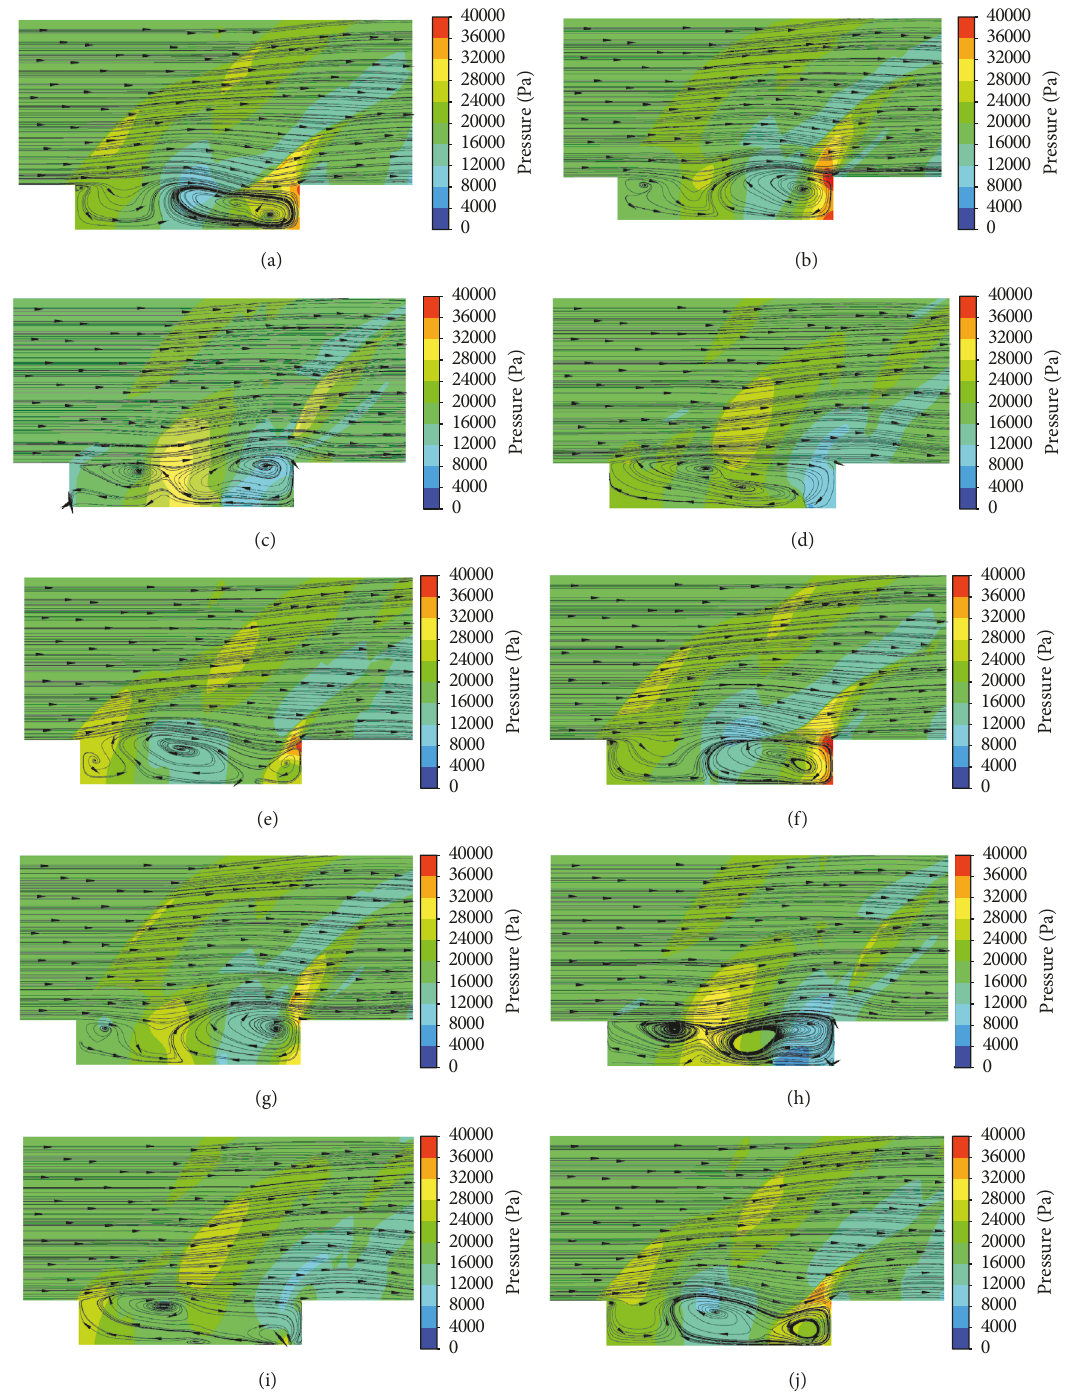
Figure 5: Pressure fluctuations of the whole domain for the baseline case (a) 𝑡/𝑡 𝑅 = 0 , (b) 𝑡/𝑡 𝑅 = 0.11 , (c) 𝑡/𝑡 𝑅 = 0.22 , (d) 𝑡/𝑡 𝑅 = 0.33 , (e) 𝑡/𝑡 = 0.44 , (f) 𝑡/𝑡 = 0.55 , (g) 𝑡/𝑡 = 0.66 , (h) 𝑡/𝑡 = 0.77 , (i) 𝑡/𝑡 = 0.88 , and (j) 𝑡/𝑡 𝑅 𝑅 𝑅 𝑅 𝑅